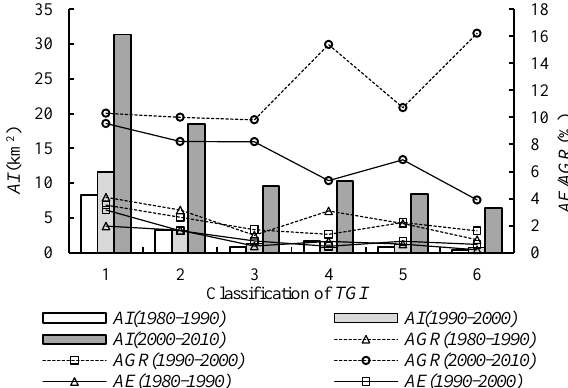
Figure 6. The relationship between traffic network and urban expansion